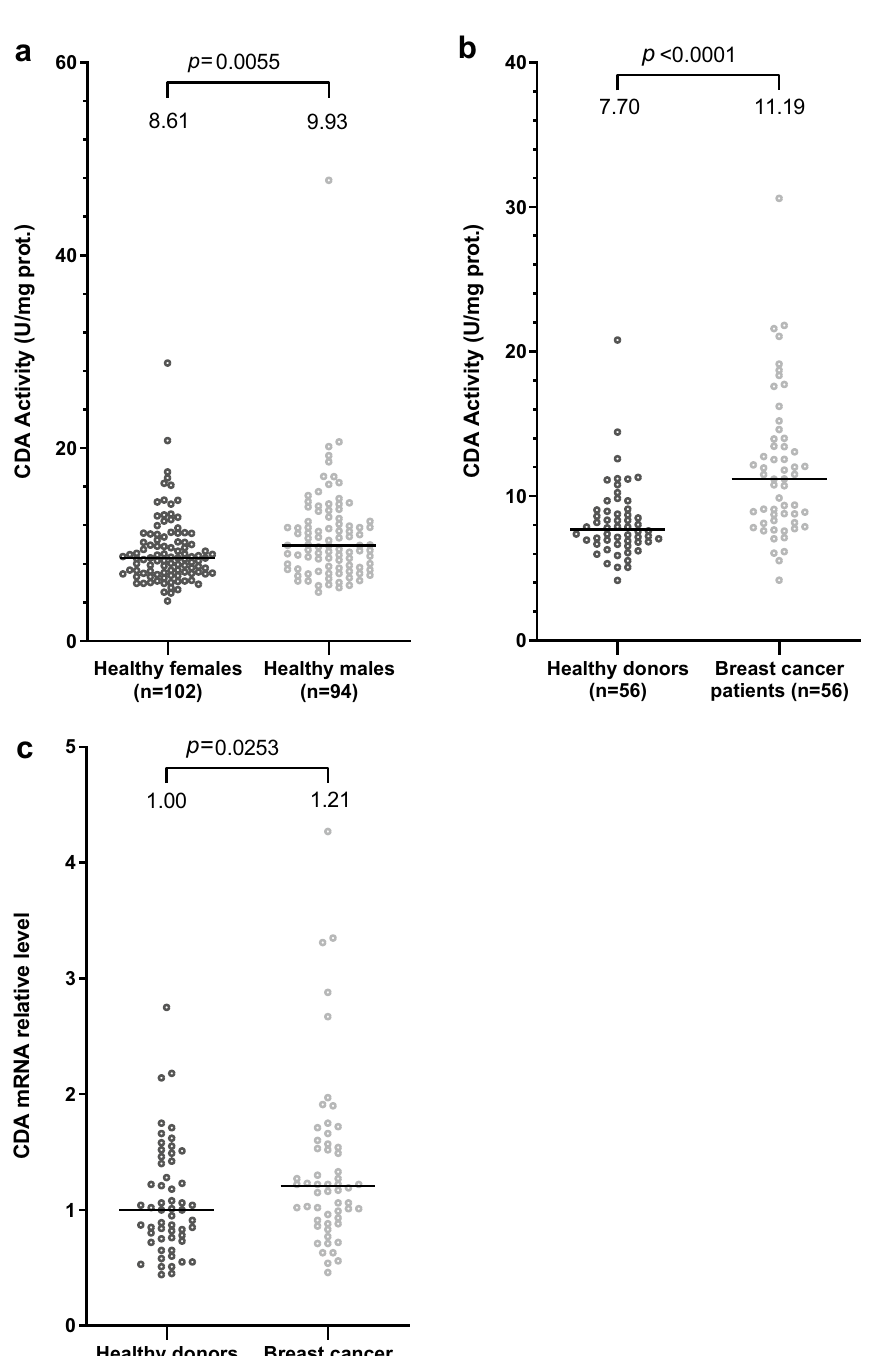
Figure 1. CDA activity and mRNA levels are significantly higher in the serum of BC patients than in that of healthy donors. ( a ) Scatter plot representation of CDA activity in enzymatic units/mg of protein for healthy female (in black) and healthy male (in gray) subjects. ( b ) Scatter plot representation of CDA activity in enzymatic units/mg of protein in matched healthy donors (in black) and BC patients (in gray). ( c ) Scatter plot representation of relative levels of CDA mRNA in matched healthy donors (in black) and BC patients (in gray). In ( b ) and ( c ), patients and controls were matched for age (± 4 years) and sex (5 male and 51 female subjects). For each panel, medians are represented by black horizontal lines and are indicated above each distribution. n is the number of individuals. Distributions were compared in Mann–Whitney tests or Wilcoxon matched- pairs signed-rank tests (see “Materials and methods” section). Values of p < 0.05 were considered statistically